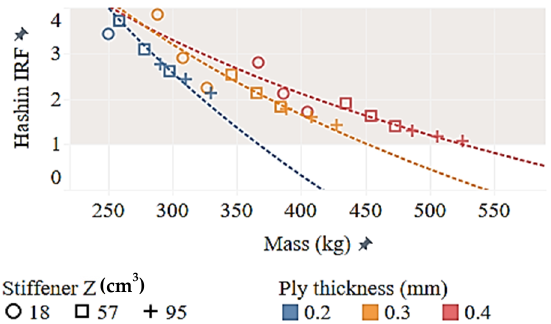
Figure 15. Influence of face ply thickness and stiffener section modulus. The stiffener section modulus are denoted by symbols while ply thickness values are denoted by colors.